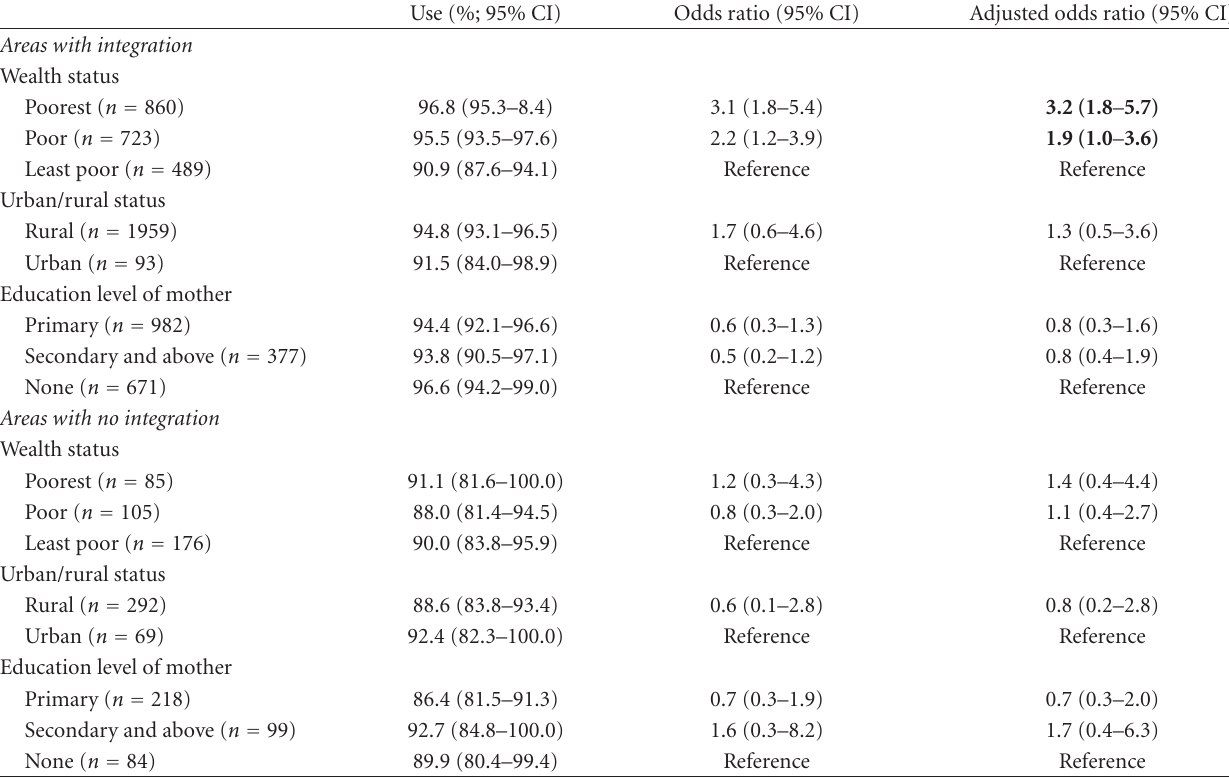
1 Abbreviations: CI = confidence interval 2 Significant adjusted odds ratios are indicated in bold